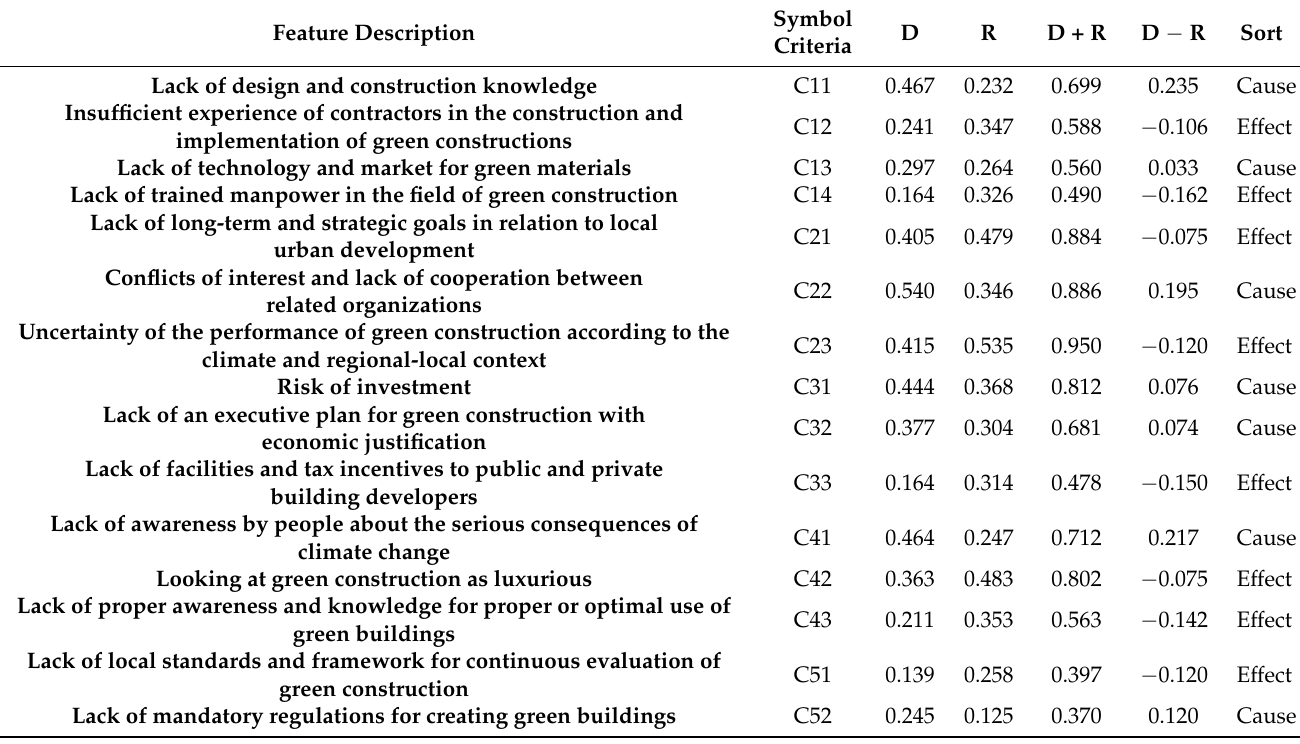
Table A2. Determined influential and influenced barriers.